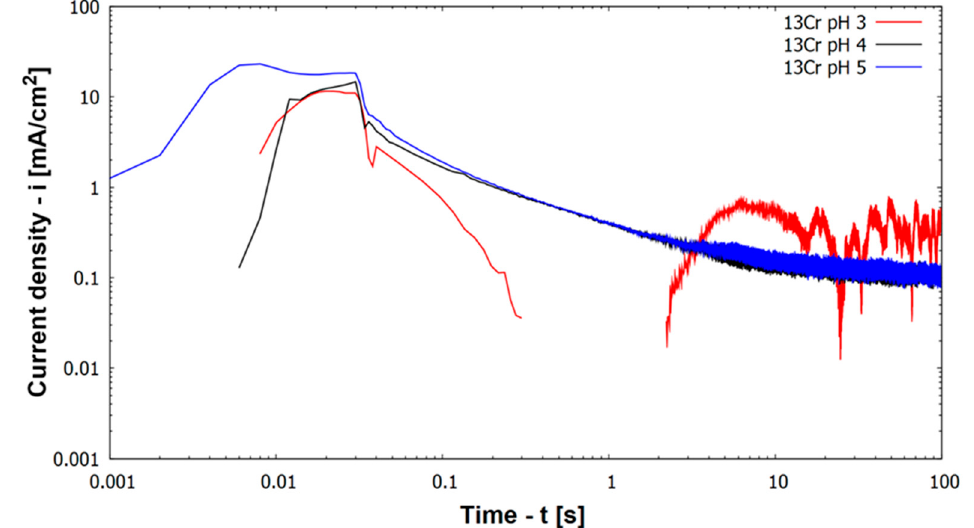
Figure 6. Current density vs. time during scratching and repassivation of 13Cr stainless steel in 30,000 ppm Cl – at 30 °C at different pH.